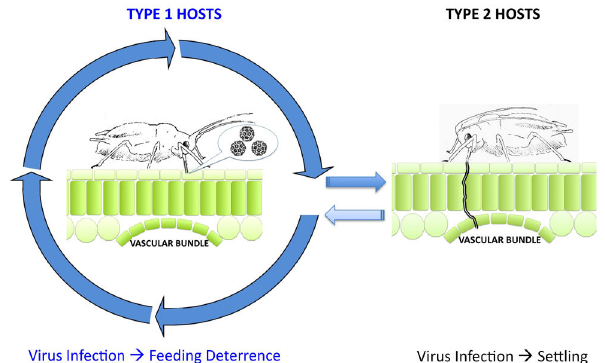
Figure 11. Hypothesis: Differential effects of